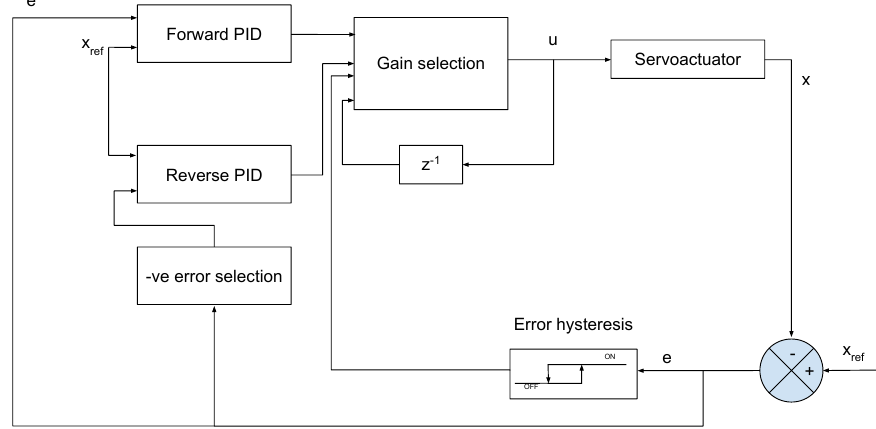
Figure 10. Schematic of the Gain-scheduled Proportional-Integral-Derivative (GSPID)